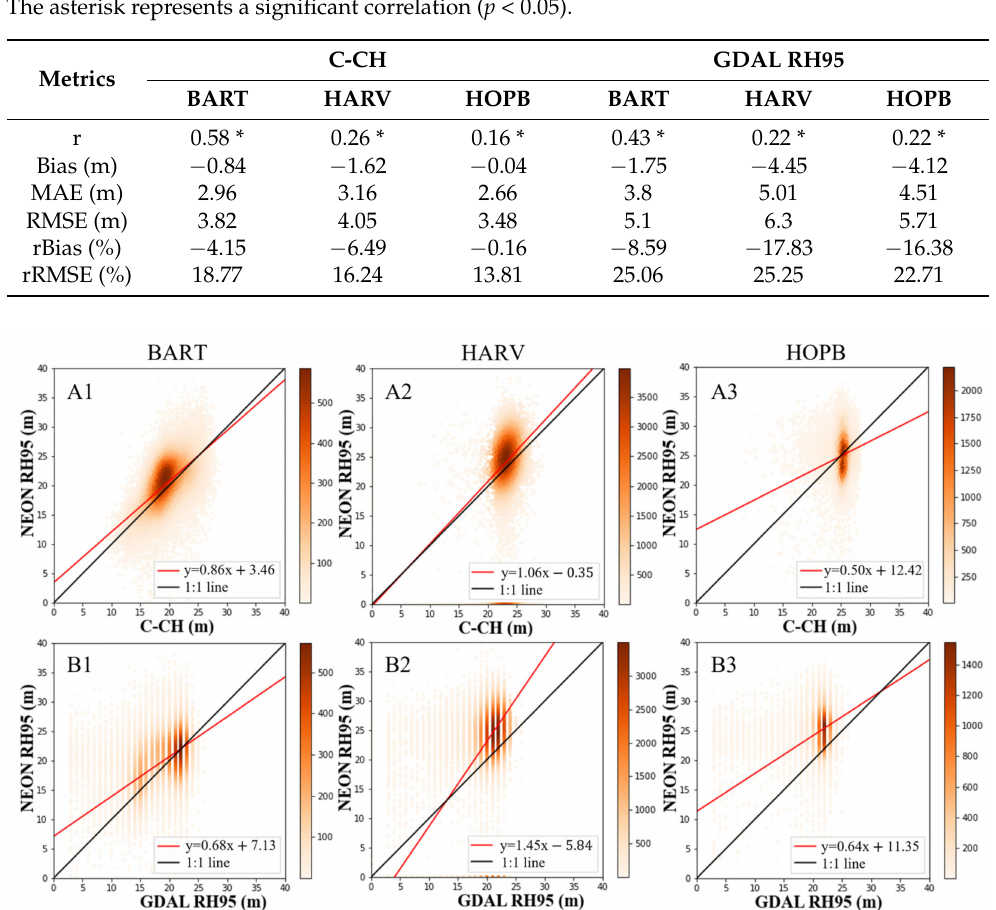
Figure 5. The relationship of canopy heights of C-CH ( A1 – A3 ) and GDAL RH95 ( B1 – B3 ) compared with NEON RH95 in BART ( A1 , B1 ), HARV ( A2 , B2 ), and HOPB ( A3 , B3 ),